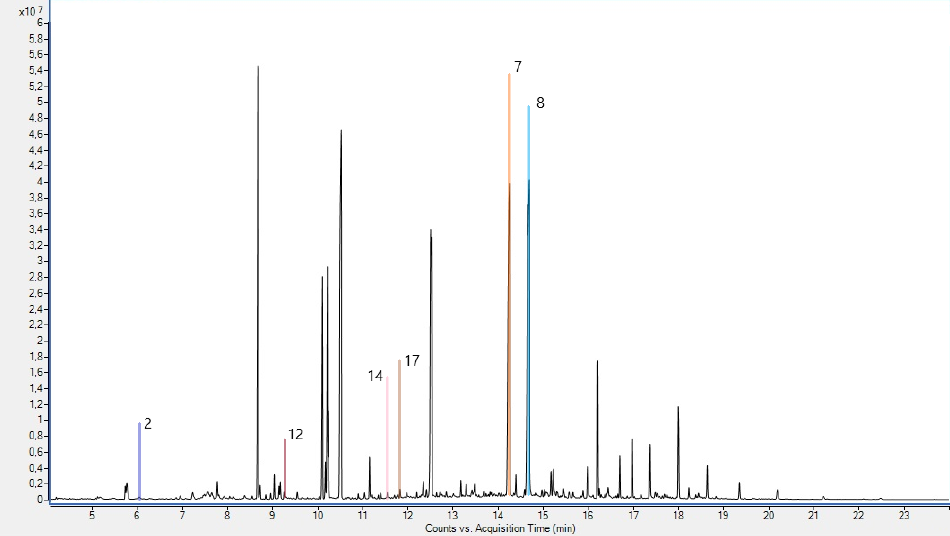
Figure 6 . Chromatogram of DCM extraction of sample Z with # ID. Figure 6. Chromatogram of DCM extraction of sample Z with #